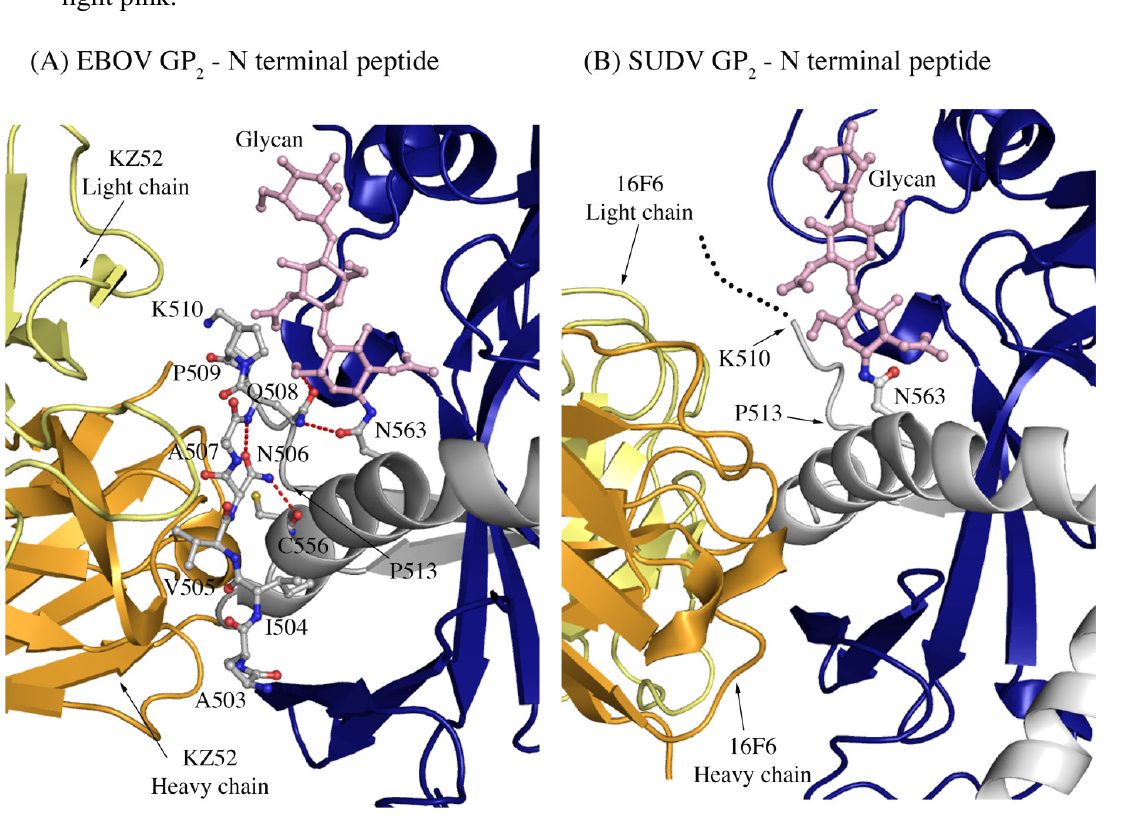
in (A) EBOV-May GP and (B) SUDV-Bon Figure 7. The N-terminal peptide of GP 2 1,2 . In both panels, GP is shown in ball-and-stick and colored grey. GP is colored GP 1,2 2 1 purple and the heavy and light chains of the antibody are colored bright orange and pale are disordered in yellow, respectively. Note that the first eight residues of GP 2 and are shown as black dots. Hydrogen bonds in (A) are shown as SUDV-Bon/-Gul GP 2 dashed red lines. There are no hydrogen bonds observed in (B) as the N-terminal peptide is disordered. The glycan residue connected to N563 is shown in ball and stick and colored light